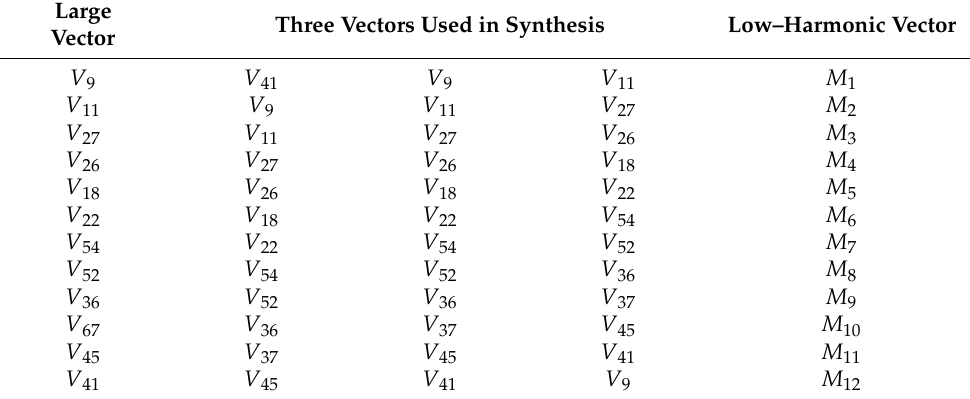
Table 2. Low–harmonic vector synthesis Table 2. Low – harmonic vector synthesis table.